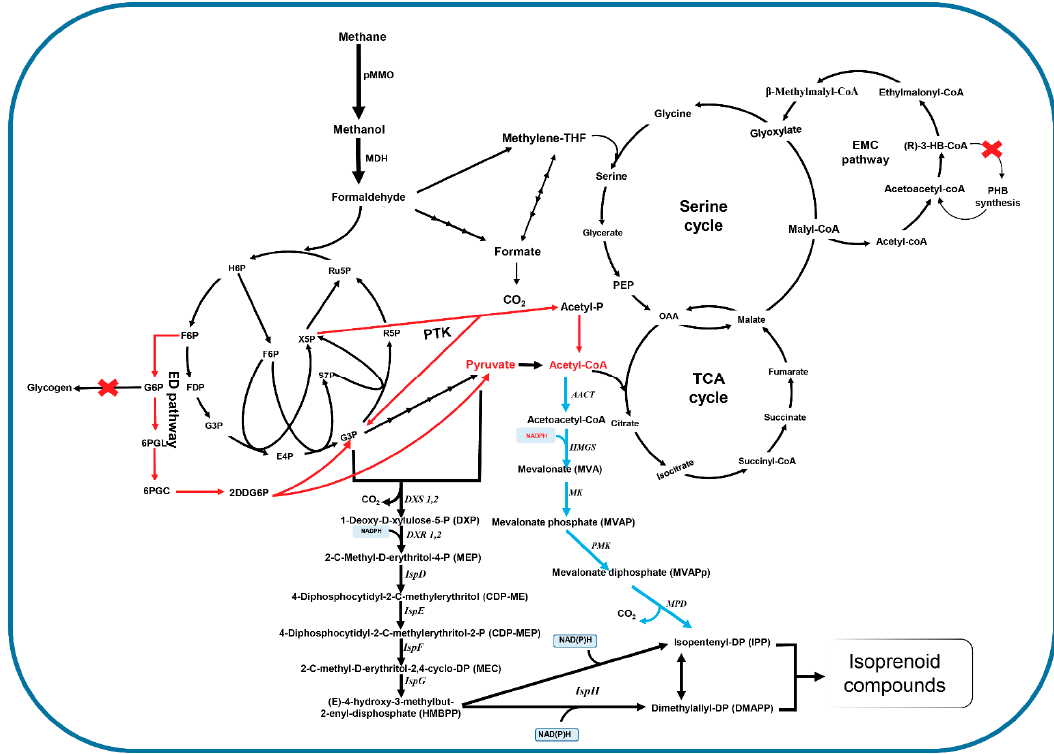
Figure 2. Central metabolism in methanotrophs and proposed engineering strategies for isoprenoid production. Red arrows: predicted overexpression targets to improve carbon conversion efficiency for production of isoprenoid via MEP and mevalonic acid (MVA) pathway; red X: suggested knockout targets for improving flux into isoprenoids; blue arrows: heterologous expression of MVA pathway in